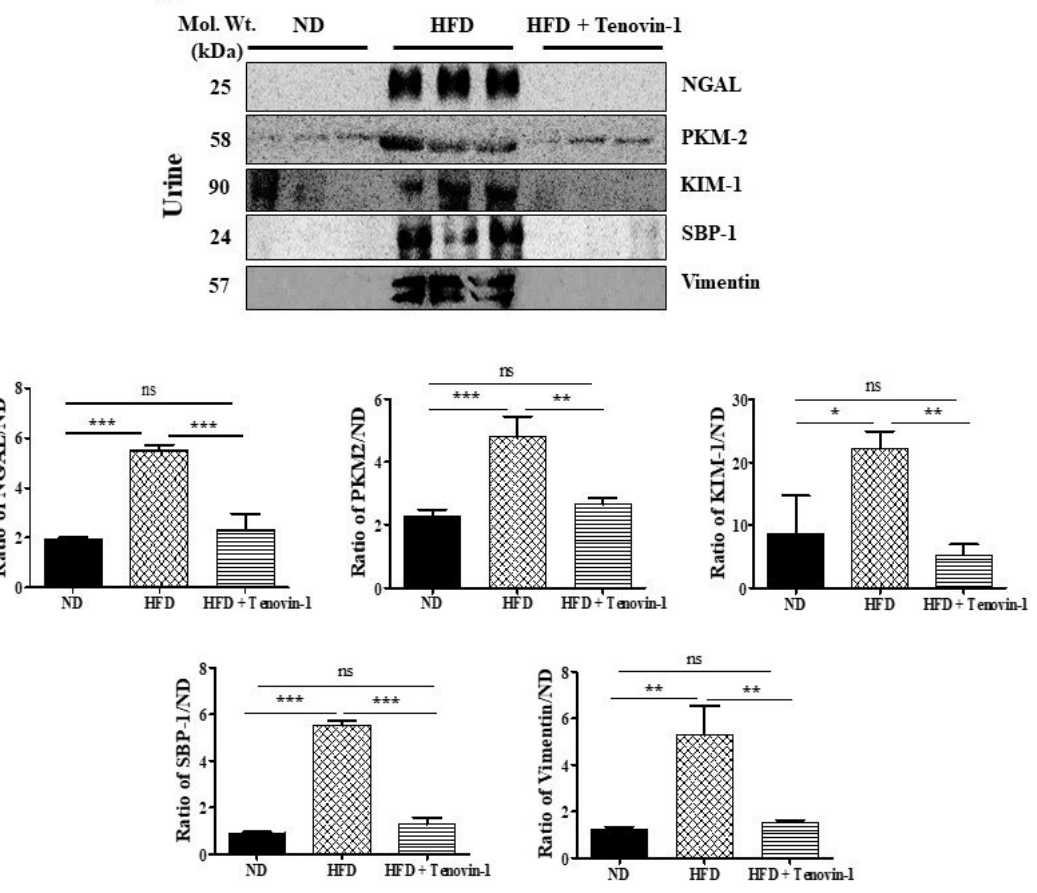
Figure 5. Effect of Tenovin-1 on the urinary excretion of indicators of kidney injury in rats with diabetes caused by the HFD. ( A ) Representative Western blots of NGAL, PKM-2, KIM-1, SBP-1, and vimentin expression in urine. Changes in the levels of kidney damage indicators in the rats with HFD-induced diabetes following Tenovin-1 treatment were observed. ( B ) Using Image J software, the band intensities were densitometrically quantified. The data are the mean ± SD of duplicate experiments (6 animals/group). Statistical analysis was performed using one-way ANOVA followed by Tukey’s HSD post hoc test for multiple comparisons (*** p < 0.001, ** p < 0.01, and * p < 0.05). “ns” (two groups are non-significant with each other). ND, normal diet; HFD, high-fat